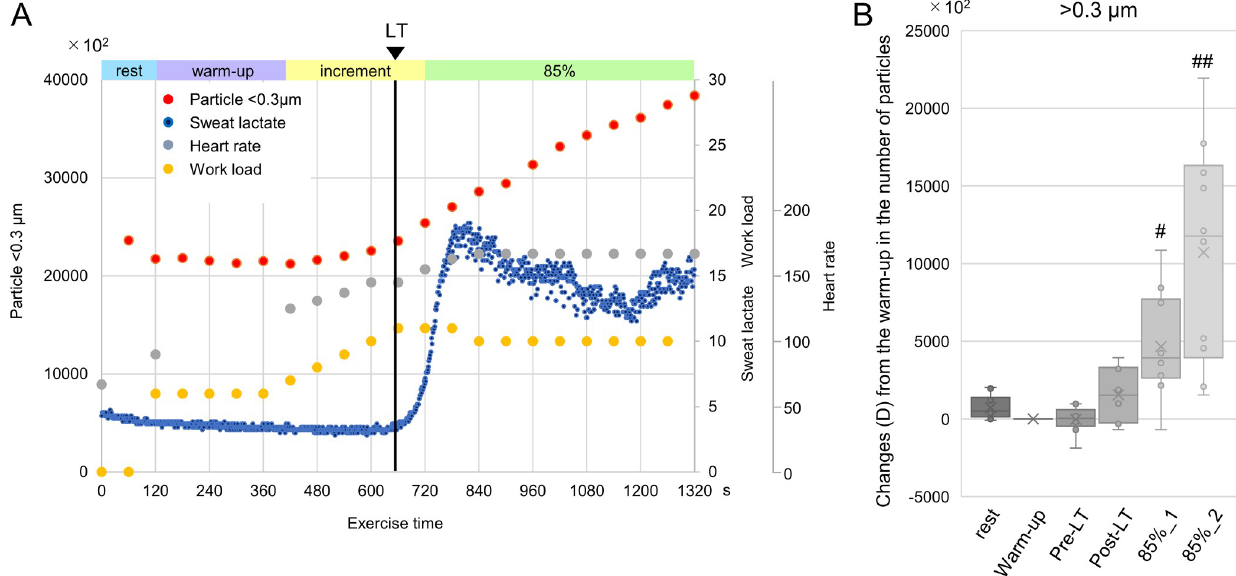
Fig 3. Airborne particulates generation during exercise. (A) Representative graphs of the concentration of airborne particulates ( < 0.3 μ m; red dots), sweat lactate (blue dots) levels, and heart rate (gray dots) during exercise. (B) Changes ( Δ ) from the warm-up in the number of airborne particulates ( > 0.3 μ m; n = 10). # p < 0.01, ## p < 0.001 compared with the warm-up. LT, lactate threshold; 85%_1, the first half of the constant-load exercise at 85% of the expected maximum heart rate; 85%_2, the latter half of the constant-load exercise at 85% of the expected maximum heart rate.